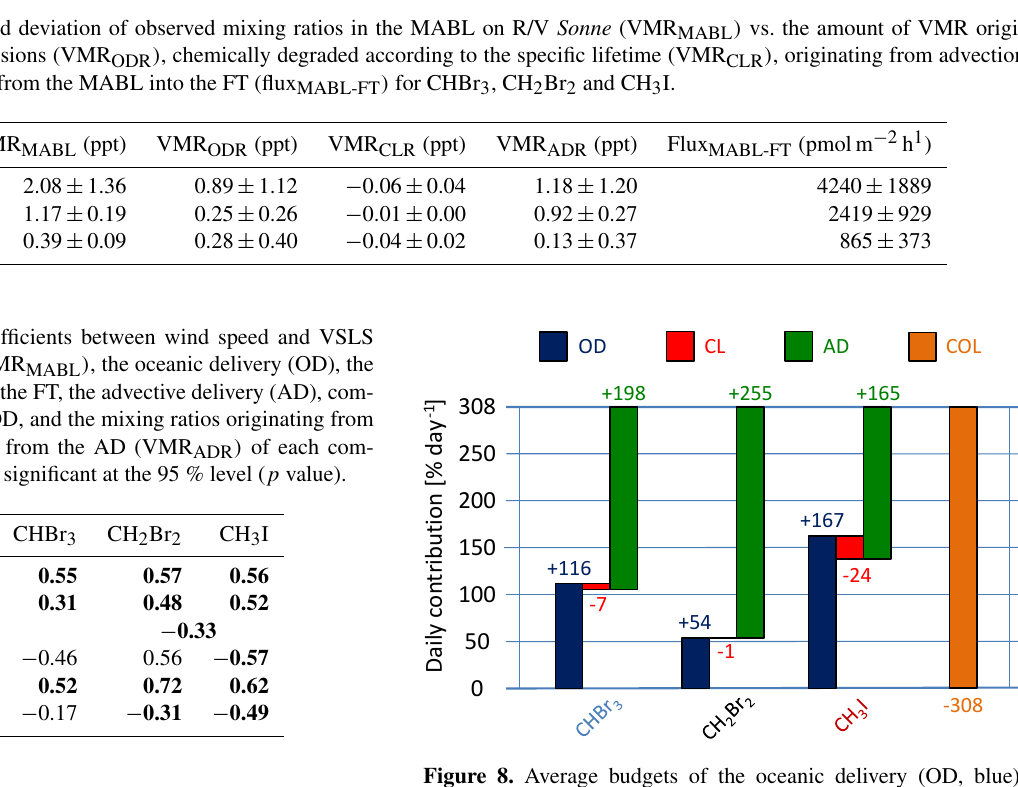
(CH 3 I) respectively (Table 5). Mixing ratios that originate from oceanic emissions (VMR ODR ) correlate significantly to the wind speed with R = 0 . 52, R = 0 . 72 and R = 0 . 62 re- spectively. In contrast, VMR ADR , which is calculated as the residual from VMR ODR , is negatively correlated to the wind speed with R = − 0 . 21, R = − 0 . 32 and R = − 0 . 53. The cor- relations reveal that the contribution of oceanic emissions to MABL VSLSs increase for higher wind speeds, while the advective contribution